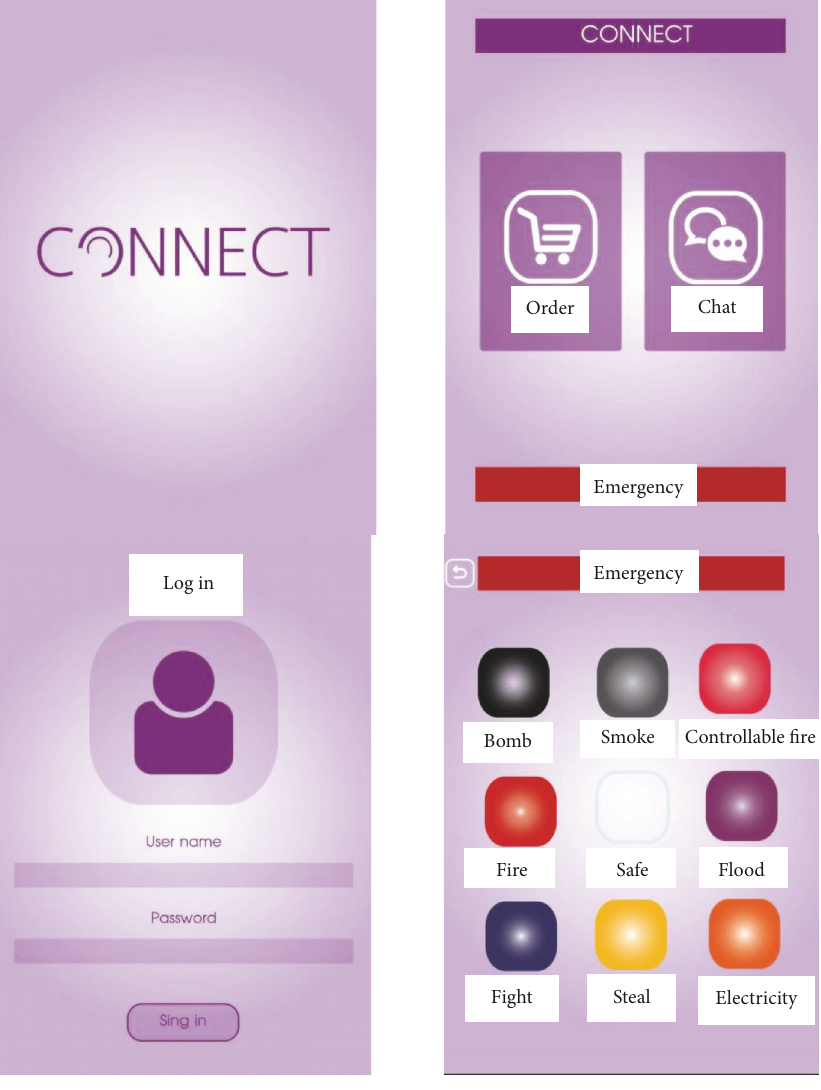
Figure 4: A mobile application used to assign a task to disabled staff [2]. Source: the current study. Table 2: Distribution test of the variable [2].